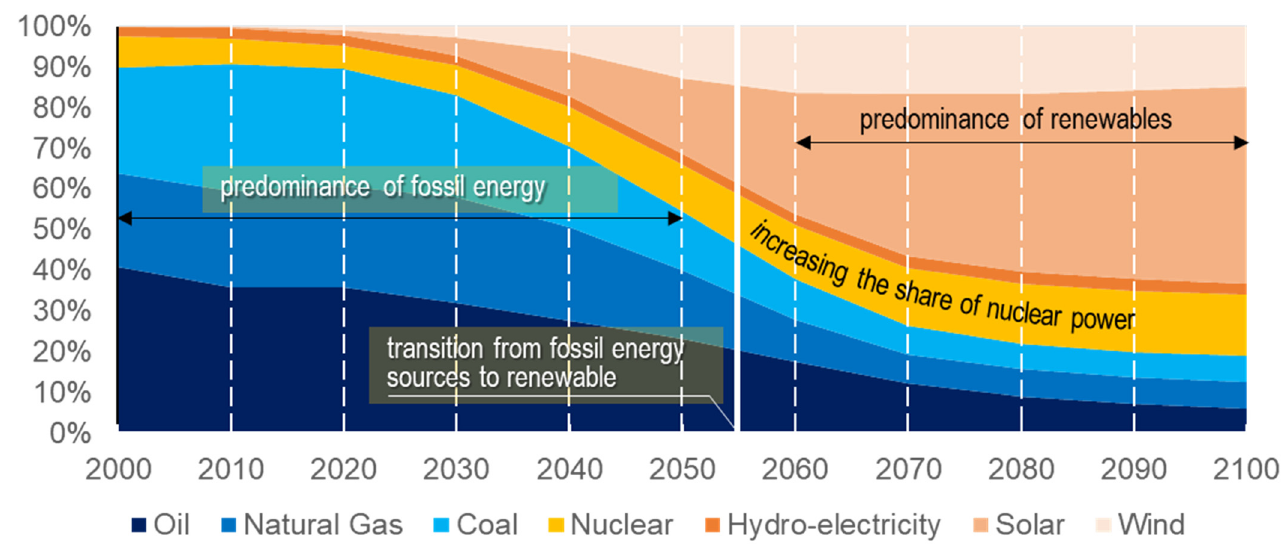
Figure 1. Energy production by fuel type. Adapted from [7].